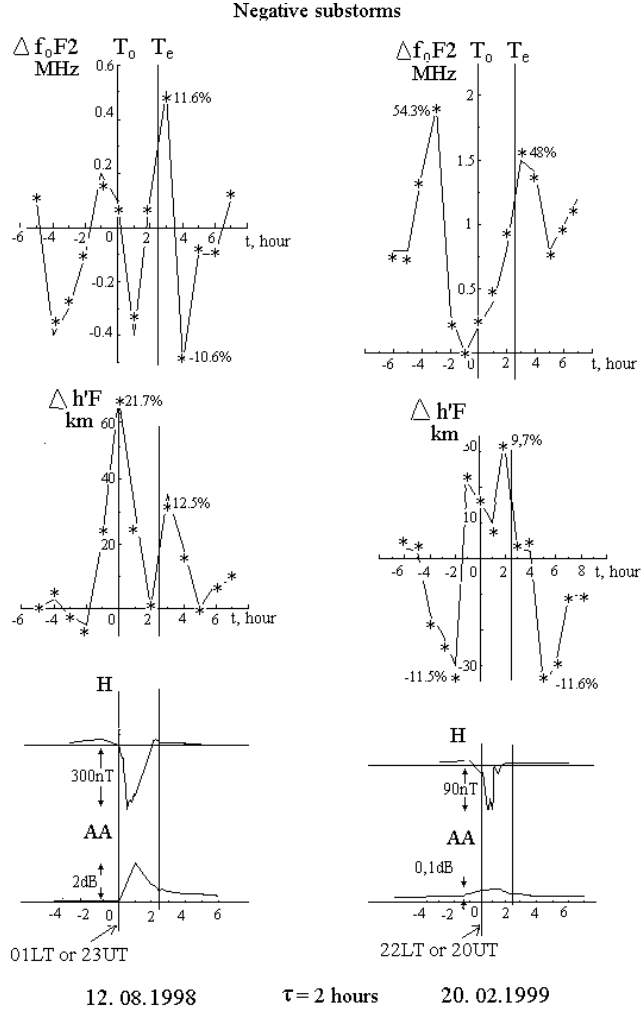
Fig. 2. The variations of 1 fo F2,MHz and 1h 0 F, km (only solid lines) for two negative substorms, together with the corresponding variations of the X -component and absorption measured at the Sodankyla observatory. The vertical lines mark substorm onset, T o , and the end of the substorm, T e . Asterisks are δ fo F2 (%) and δh 0 F (%) reduced to the maximum